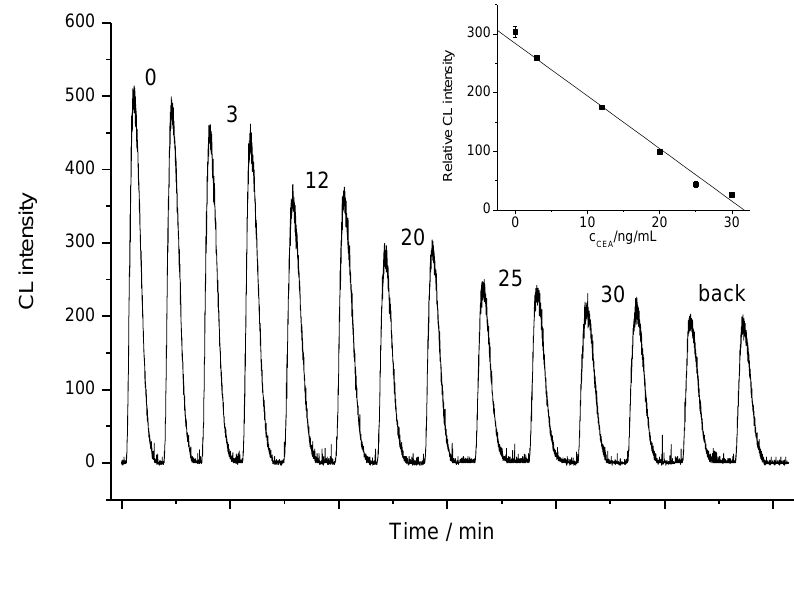
Figure 4. Dose-response curve for CEA. Inset: Plots of CL intensity versus CEA concentration in pre-incubation